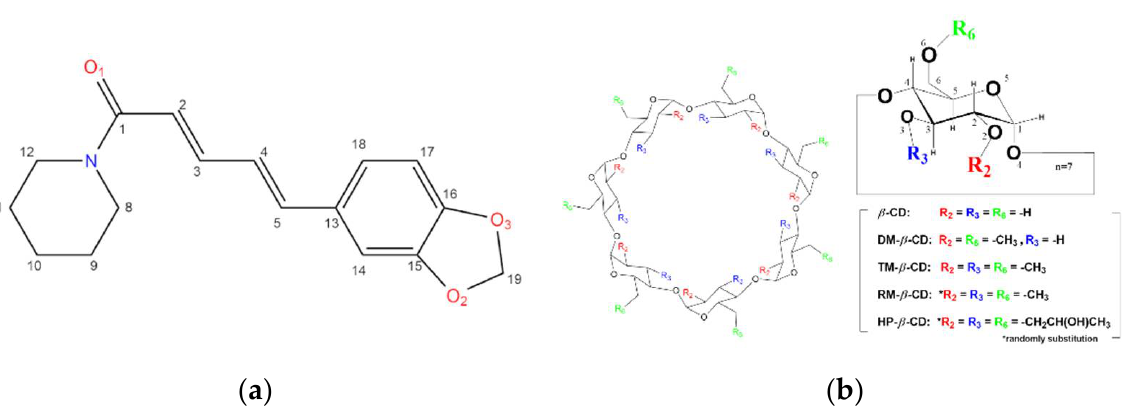
Figure 1. Schematic representation of the chemical structure of ( a ) Piperine (PN); ( b ) β -cyclodextrin ( β- CD), heptakis(2,6-di- O -methyl)- β -cyclodextrin (DM- β- CD), heptakis(2,3,6-tri- O -methyl)- β - cyclodextrin (TM- β- CD), randomly-methylated- β -cyclodextrin (RM- β- CD) and 2-hydroxypropyl- β - cyclodextrin (HP- β- CD).